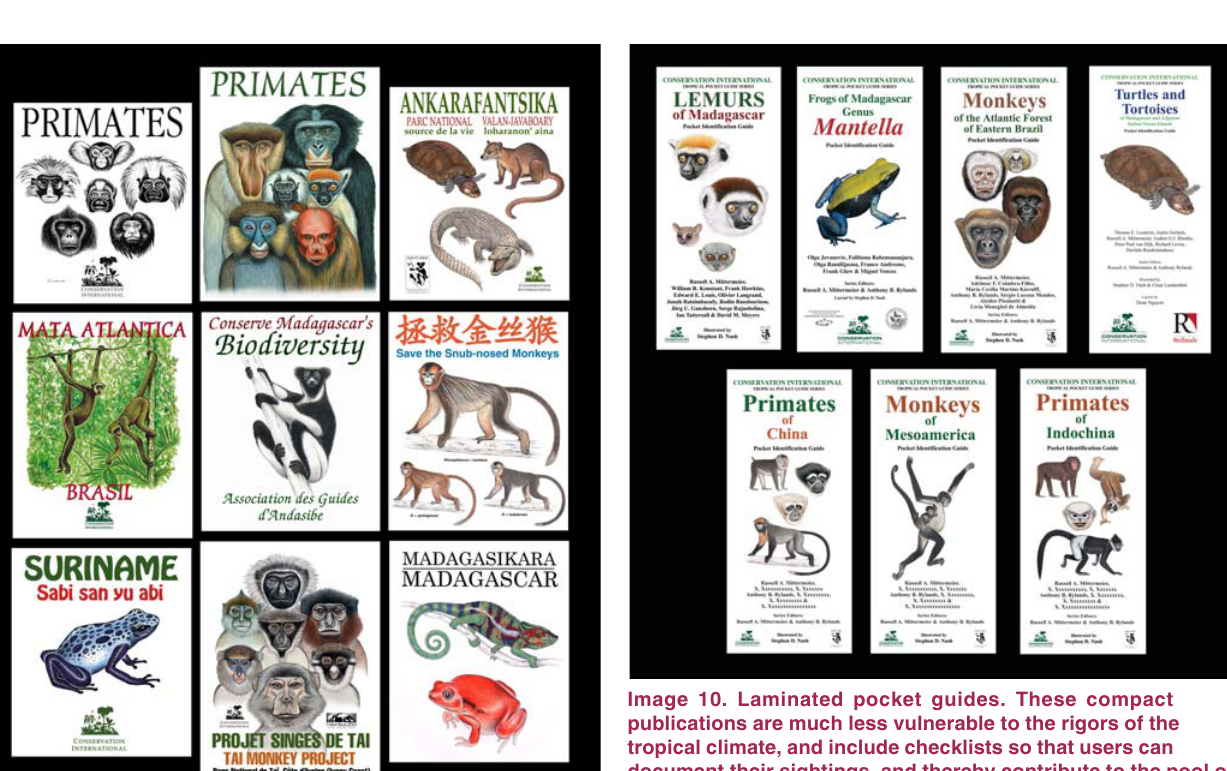
Image 9. These posters are some of the many produced as part of educational campaigns over the years. The one in the center at the top has been used by customs officials to identify endangered primates being trafficked under false names. (Illustrations by CI/Stephen D.